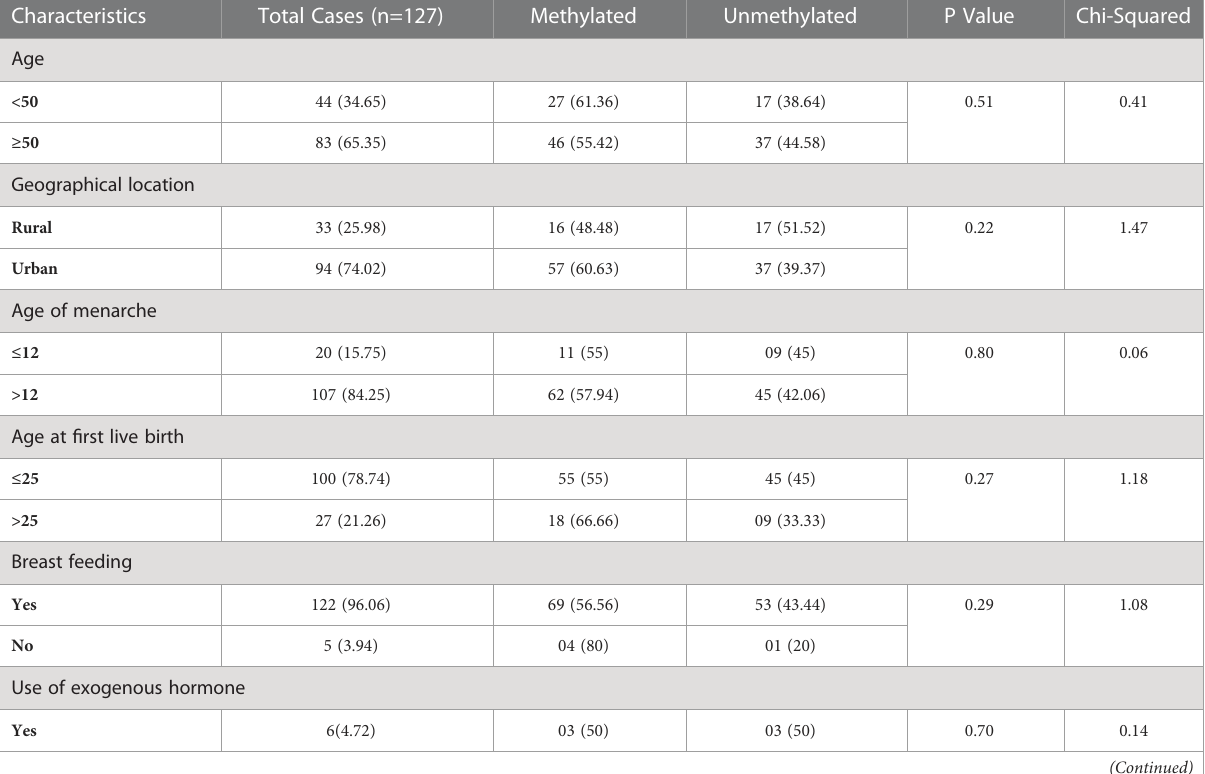
TABLE 4 Correlation study of FOXO3 Promoter Methylation status with clinical parameters of Breast Cancer Patients.